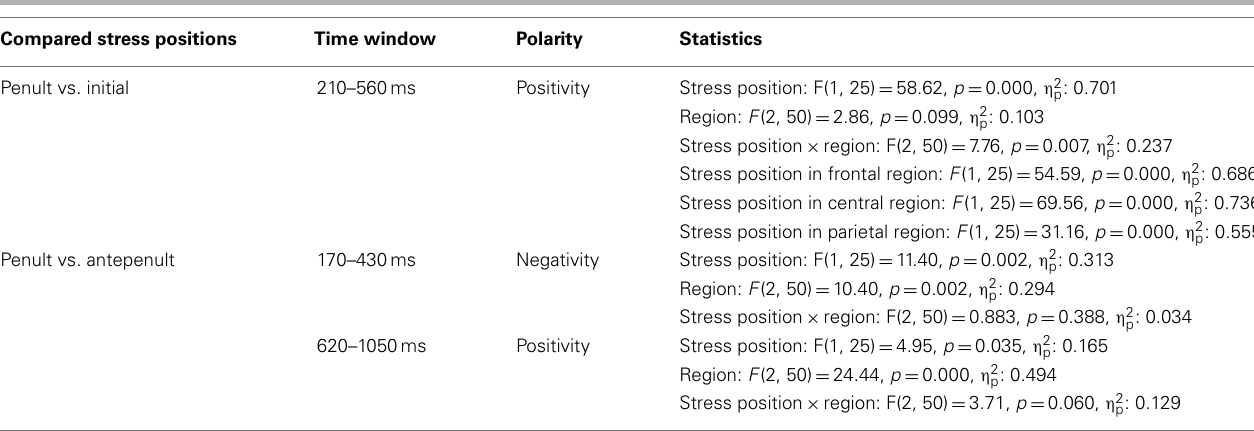
p-ValuesareHuynh–Feldt-correctedandeffectsizesaregivenaspartialetasquaredvalues( η 2 are